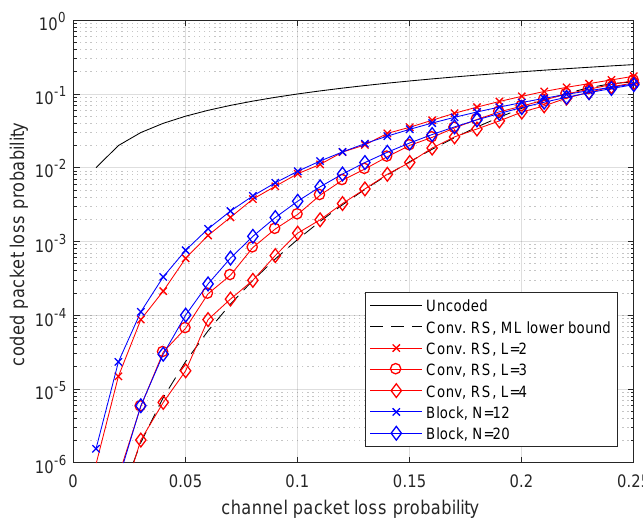
Figure 7. Comparison of RS-block codes and the RS-convolutional code for different delays.